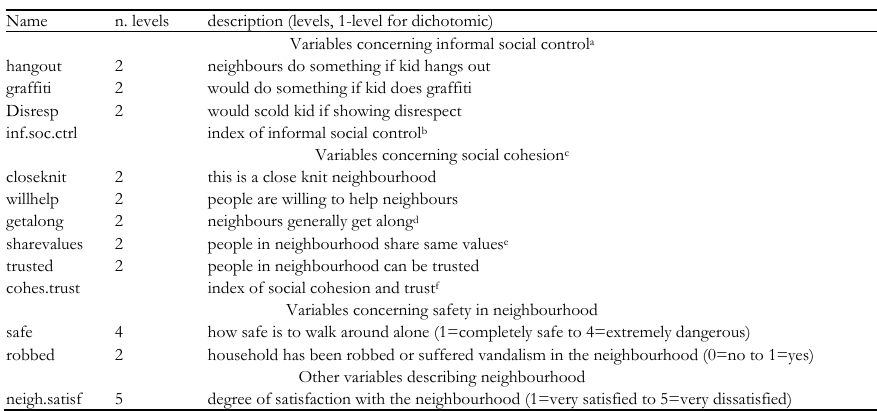
Relevant variables related to neighbourhood in